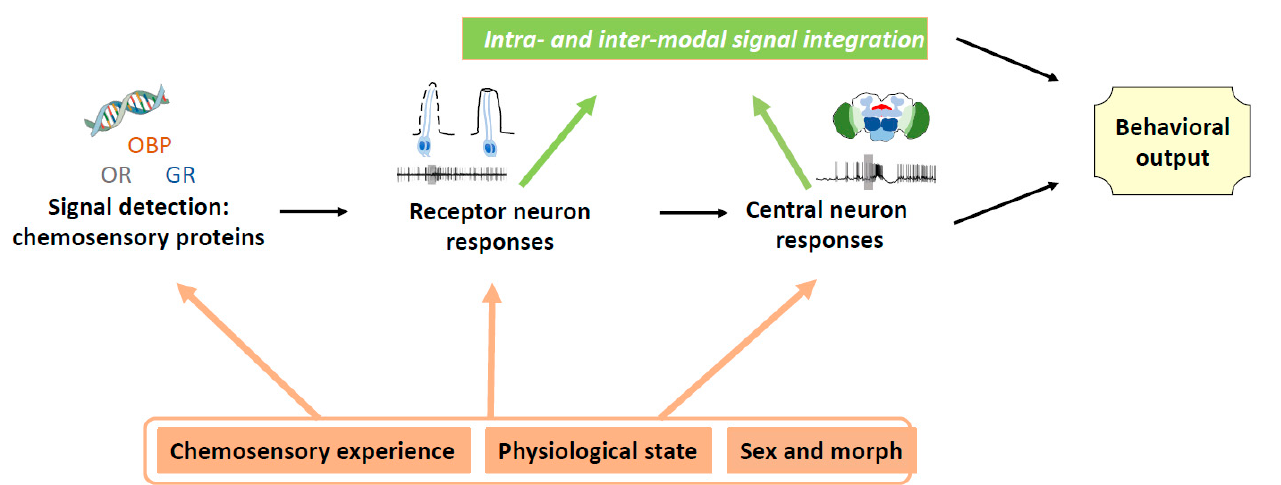
Figure 1. Mechanisms involved in chemosensory plasticity at different integration levels, leading to modulation of behavioral output. GR gustatory receptor, OBP odorant binding protein, OR odorant receptor.